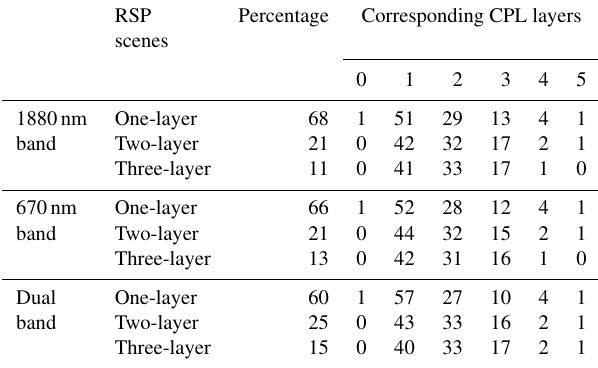
Table 2. The 1880nm band RSP cloud layer percentages compared with